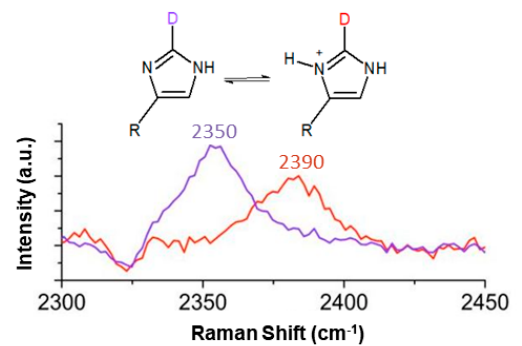
Figure 2. The C2-D Raman stretch from the imidazole sidechain of histidine is sensitive to the protonation state of the neighboring N atoms. The protonated and deprotonated imidazole ring C2-D stretches were observed at 2390 cm − 1 (red curve; pH 2.5) and 2350 cm − 1 (purple curve; pH 9.8), respectively. Adapted with permission from [30]. Copyright 2013 American Chemical Society.